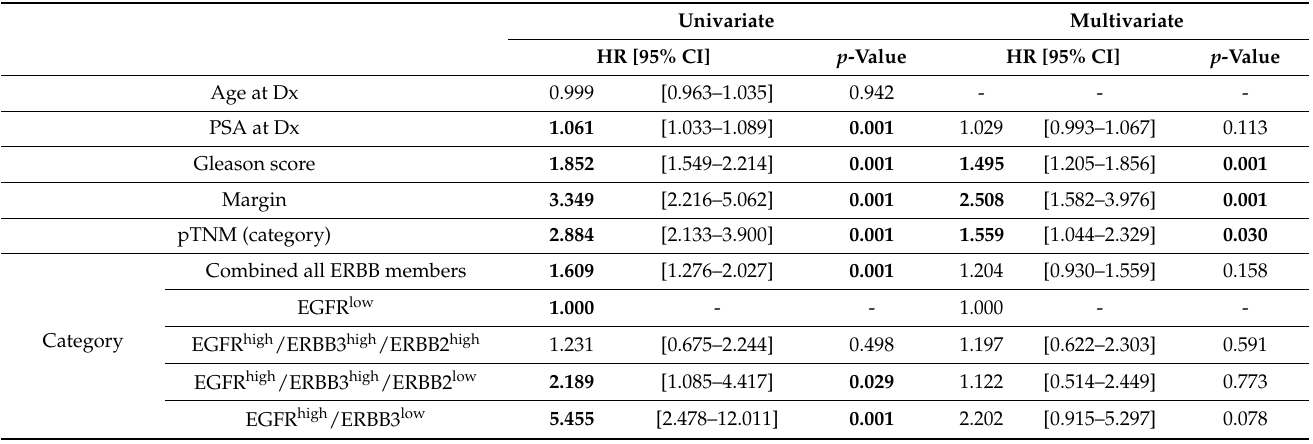
Table 3. Univariate and multivariate Cox regression analyses of the ERBB status groups using the BCR at five years as an endpoint.